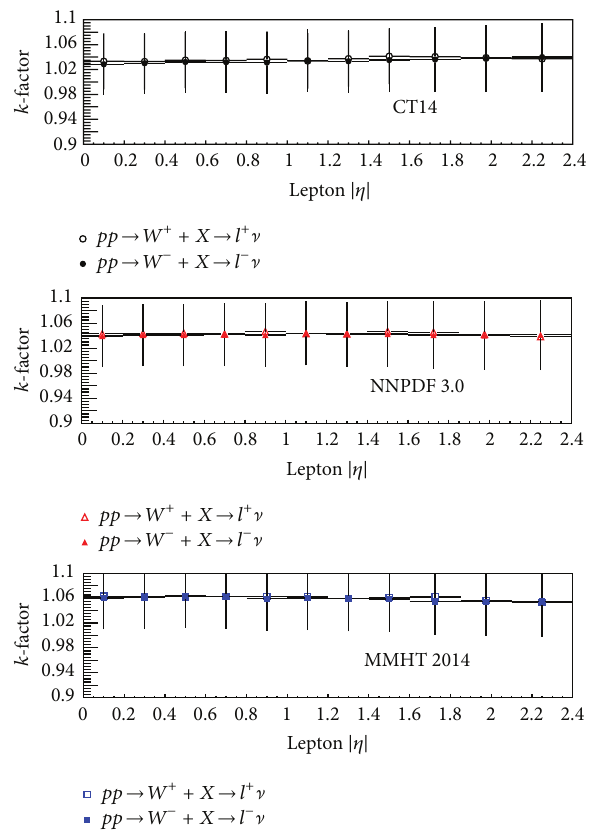
Figure 5: 𝑘 -Factor distributions for 𝑊 + and 𝑊 − at √𝑠 = 13